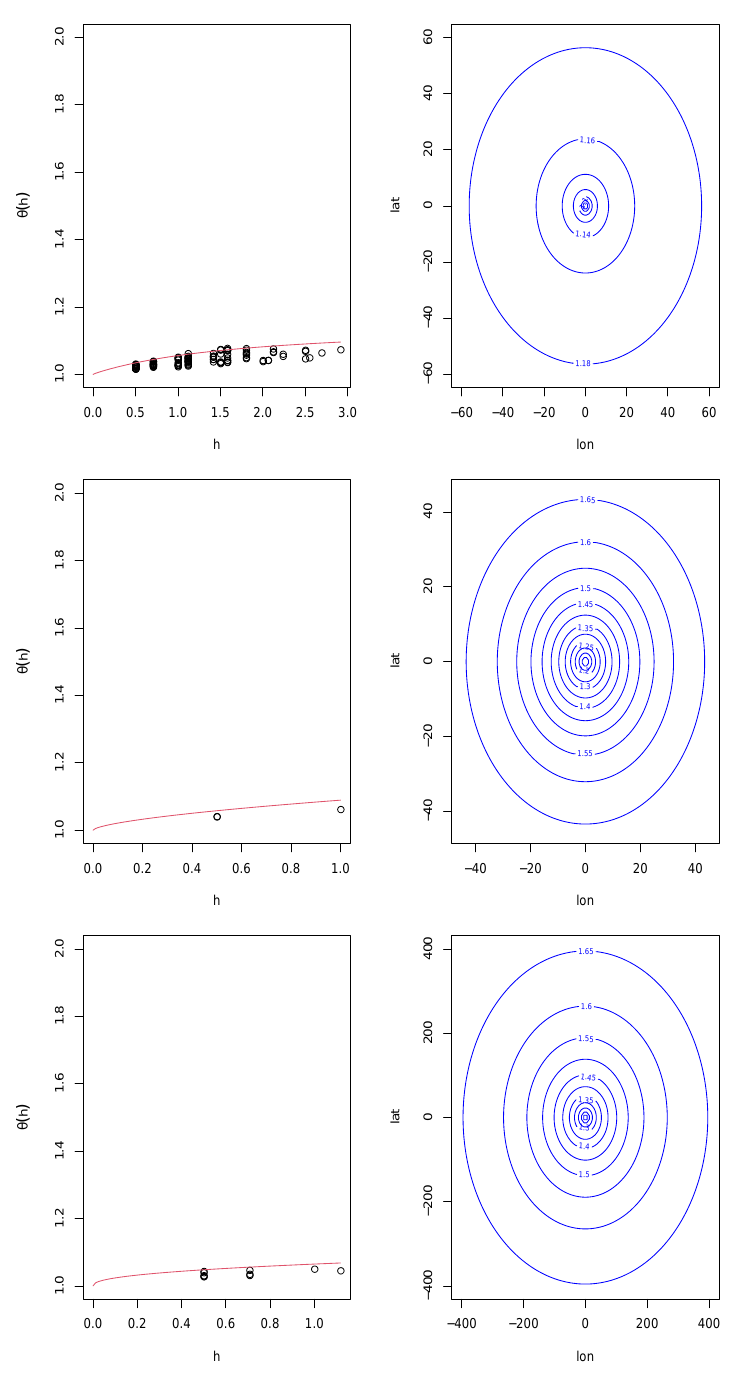
Figure 10. ( Top panel ) Cluster 1, ( Middle panel ), cluster 2 and ( Bottom panel ) cluster 3 plots of (i) first column extremal coefficient θ ( h ) against distance h for the maximum annual temperature and (ii) second column extremal coefficient changes as longitudes and latitudes